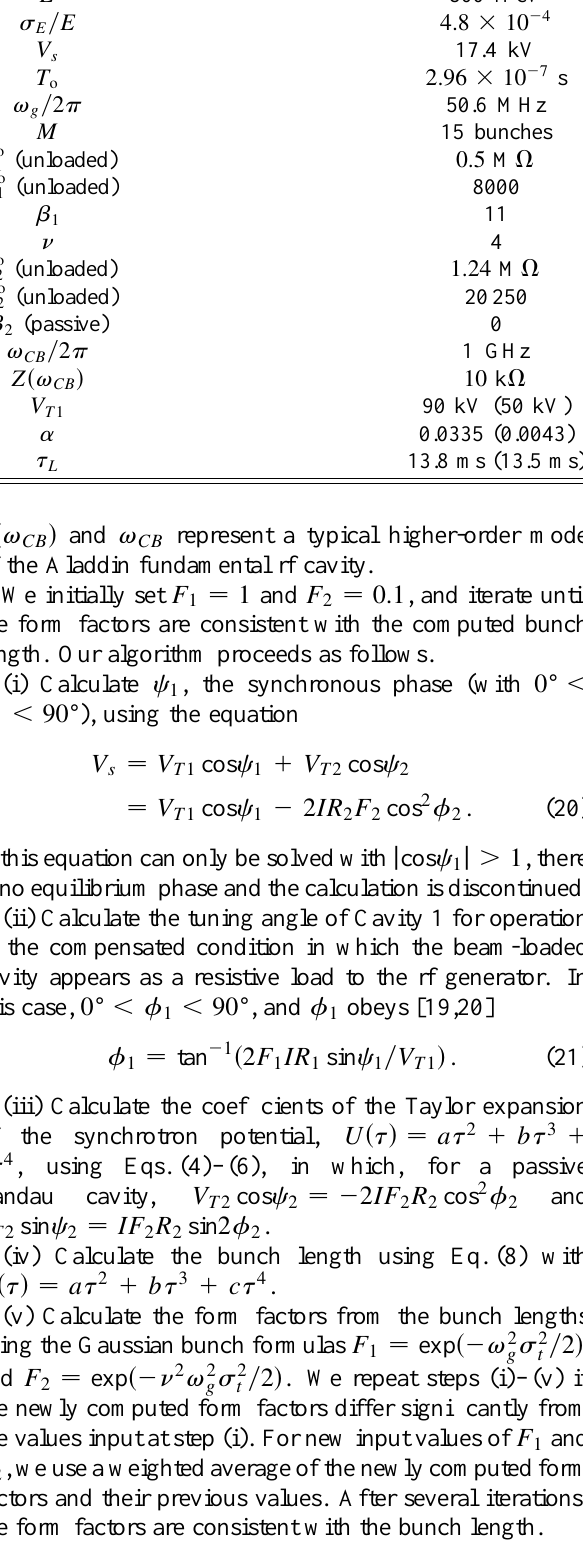
TABLE I. Standard Aladdin parameters, with low-emittance (LF20) values of V T 1 , a , and t L in parentheses.